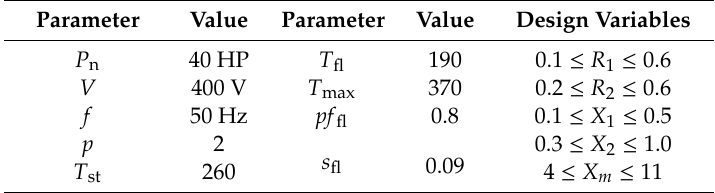
Table 8. Data of Machine 1 [14].